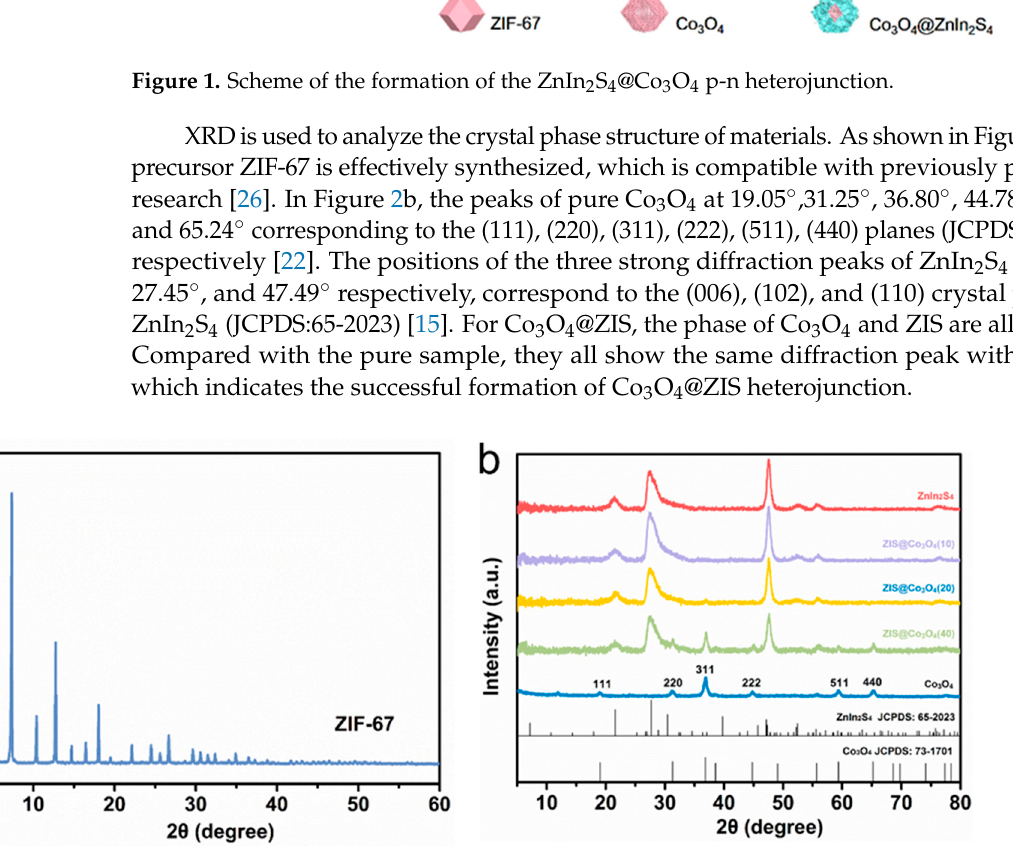
Figure 2. XRD spectra of all samples: ( a ) ZIF-67; ( b ) Co 3 O 4 , ZnIn 2 S 4 , Co 3 O 4 (10)@ZIS, Co 3 O 4 (20)@ZIS, Co 3 O 4